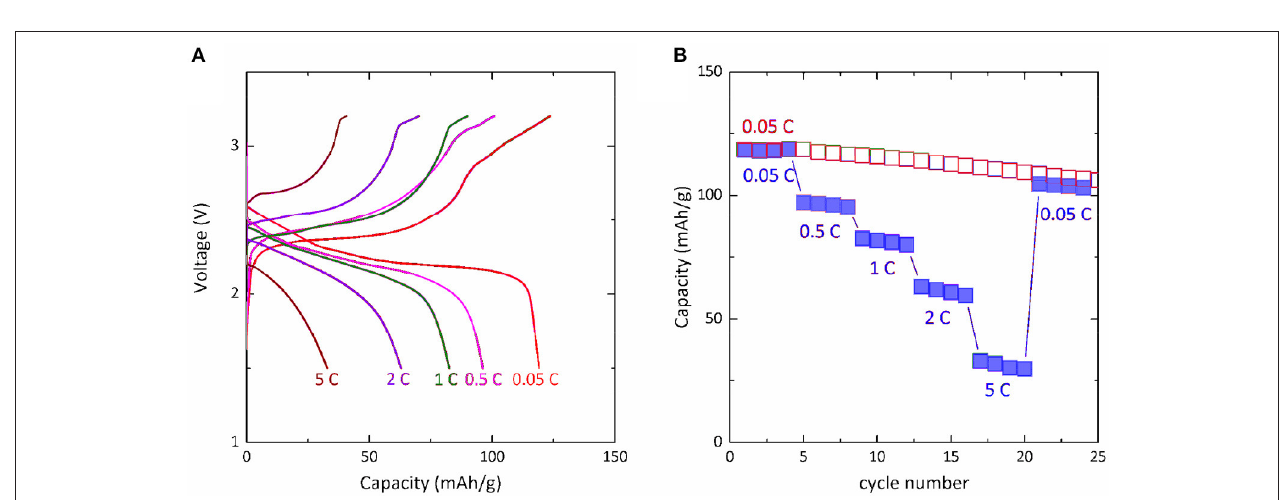
FIGURE 5 | Rate performance of Mg-NaCrO 2 hybrid cell. (A) Charge-discharge profile at different C rates. (B) Capacity retention at high rate cycling.